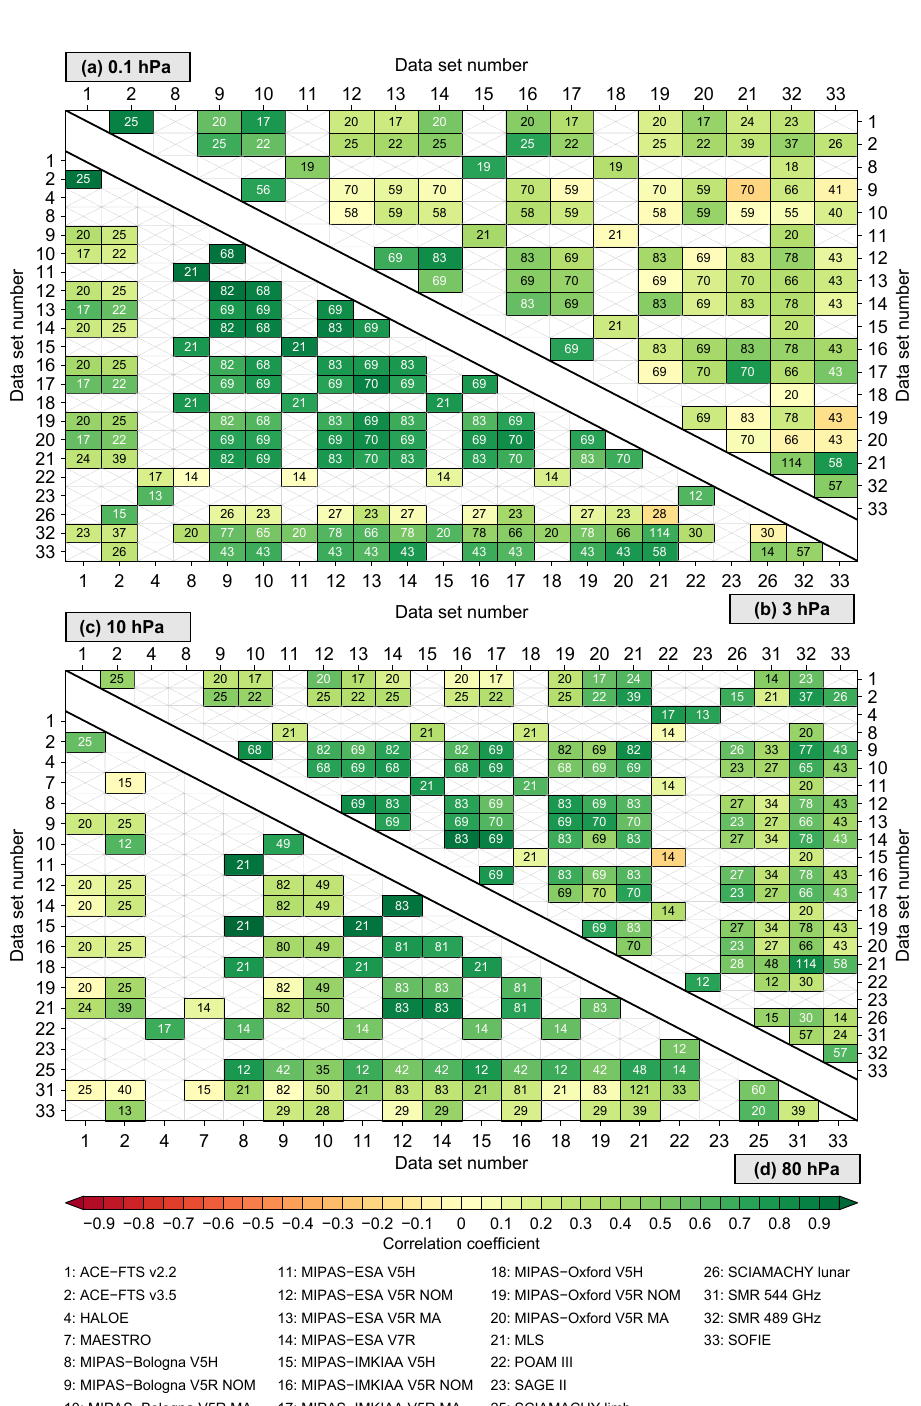
Figure 7. The correlations between de-seasonalised time series in the latitude band between 80 ◦ and 70 ◦ S. The upper panel considers the 0.1hPa (a) and 3hPa (b) pressure levels, while in the lower panel the results at 10hPa (c) and 80hPa (d) are shown. Only data sets yielding any result at a given altitude are shown. Thus, the number of data sets can vary from altitude to altitude. Comparisons yielding no results are indicated by grey crosses. For comparisons with results (the coloured boxes) the number of months the two data sets actually overlap (i.e. both yield a valid monthly mean) are